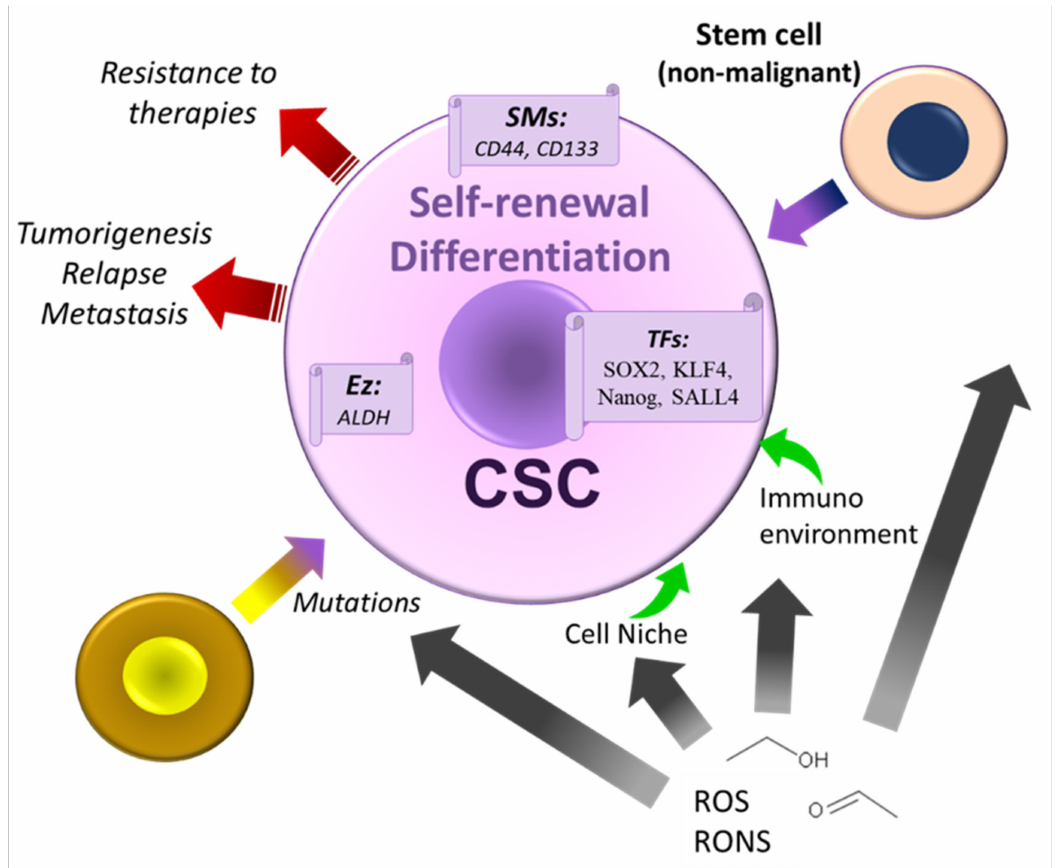
Figure 8. Schematic representation of a cancer stem cell (CSC) generated from non-malignant progenitor stem cells or somatic and differentiated cells by altering essential signaling pathways, epigenetic mechanisms, and mutations. Ethanol and its metabolites may interfere with critical molecular events related to signaling pathways, gene expression regulators, and environmental factors and consolidate CSC phenotypes and clonal heterogeneity within a tumor in different tissues (see text for details). Labels (Ez, SMs, and TFs) indicate markers that characterize CSCs. ALDH, aldehyde dehydrogenase; Ez, enzymes; SMs, cell surface markers; TFs, transcription factors